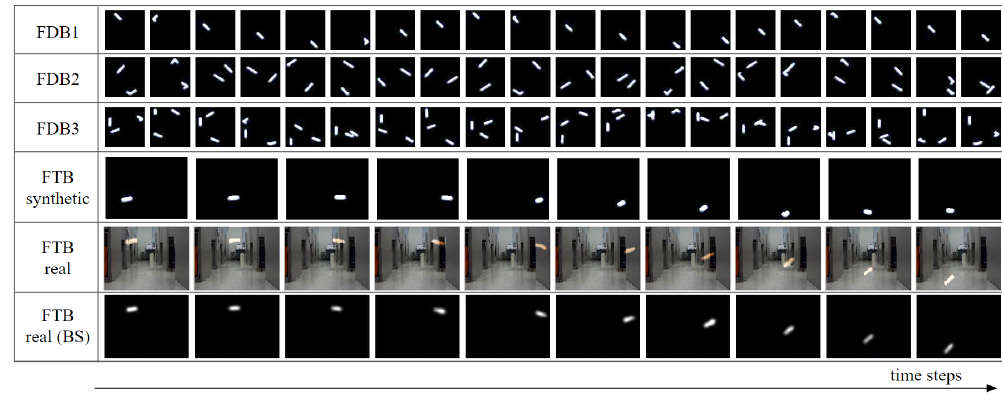
Figure 7. Dataset examples.